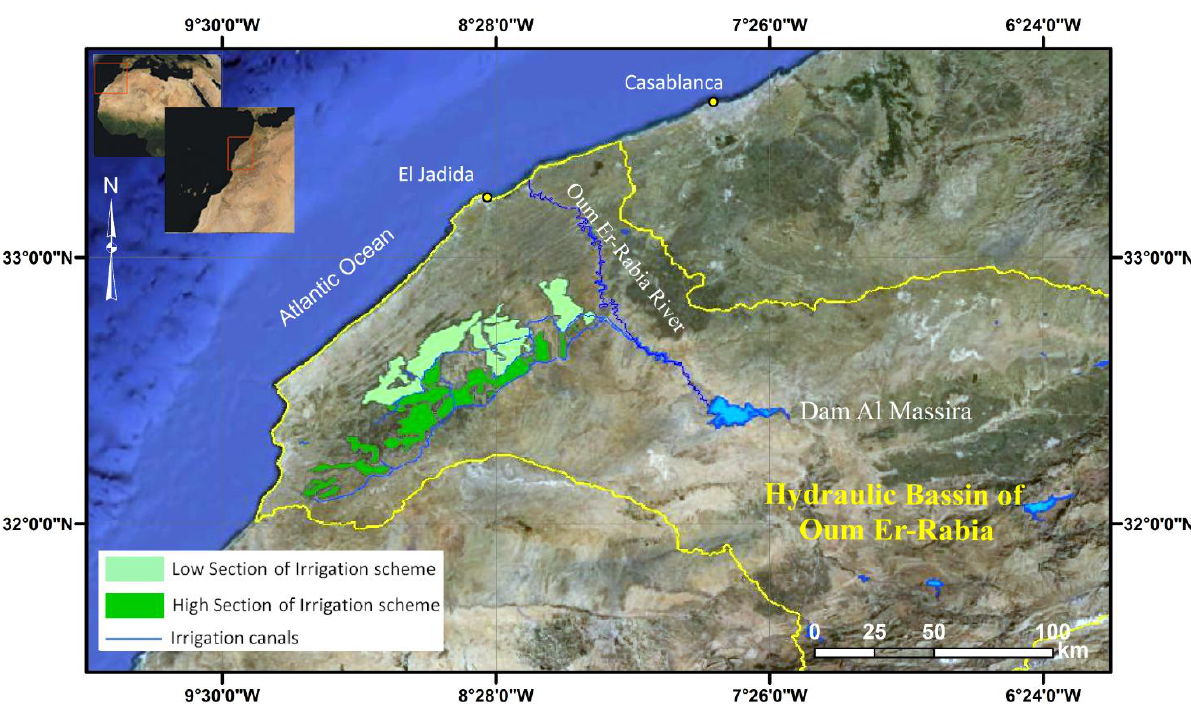
Figure 1. Location map of Doukkala